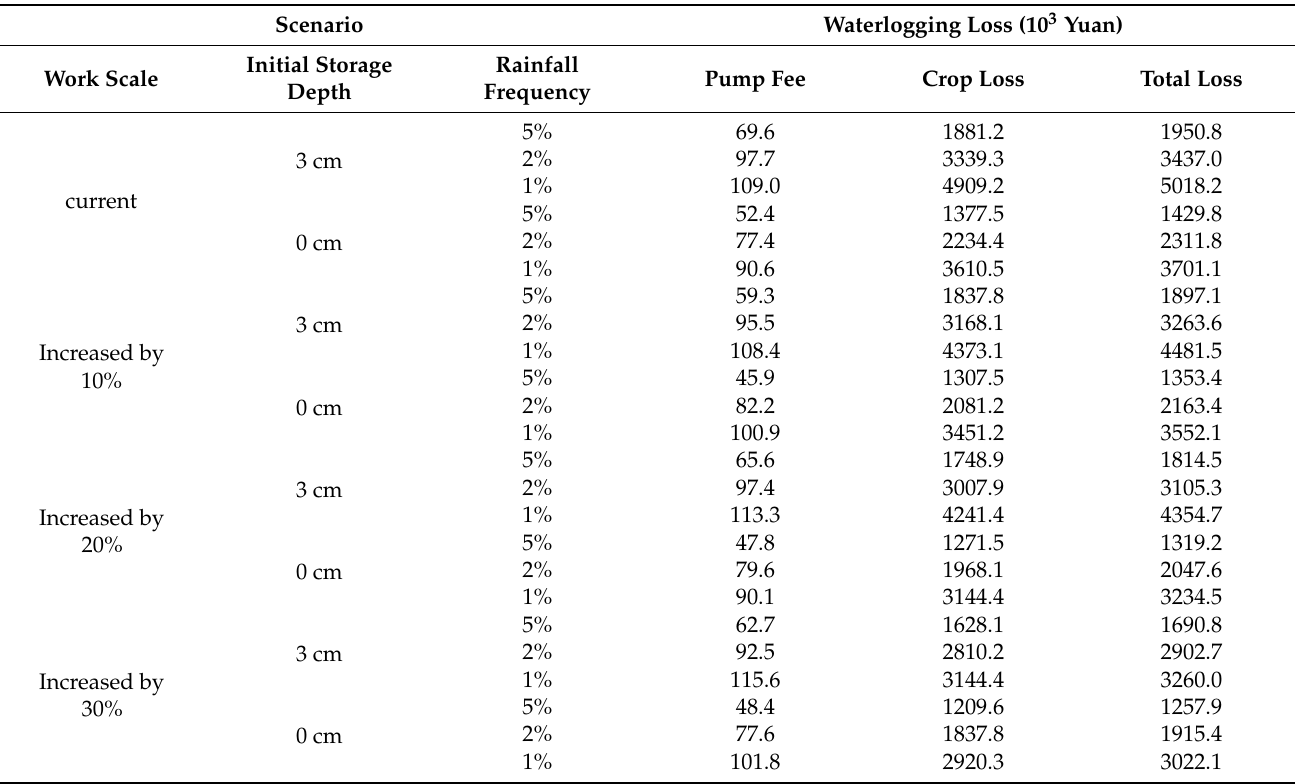
Table 4. Waterlogging loss under different